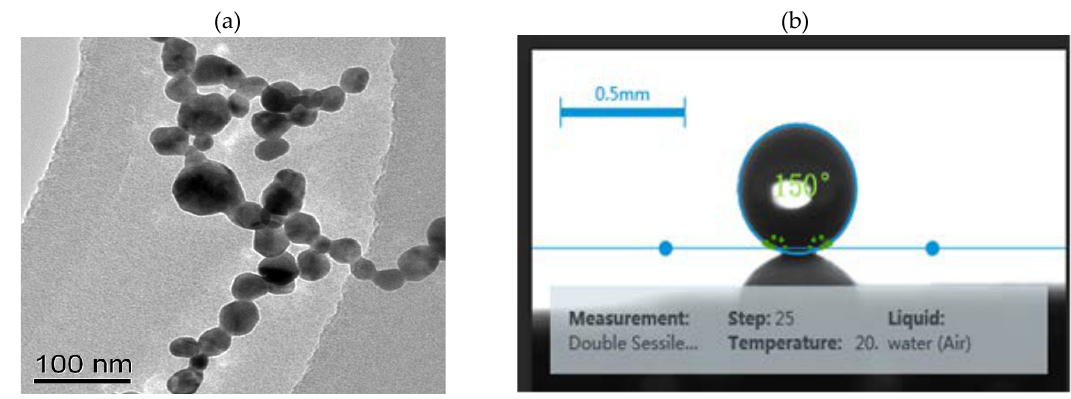
Figure 3. (a) Transmission electron microscopy (TEM) image of Ag nanospheres and (b) Static contact angle of the super-hydrophobic silver film.